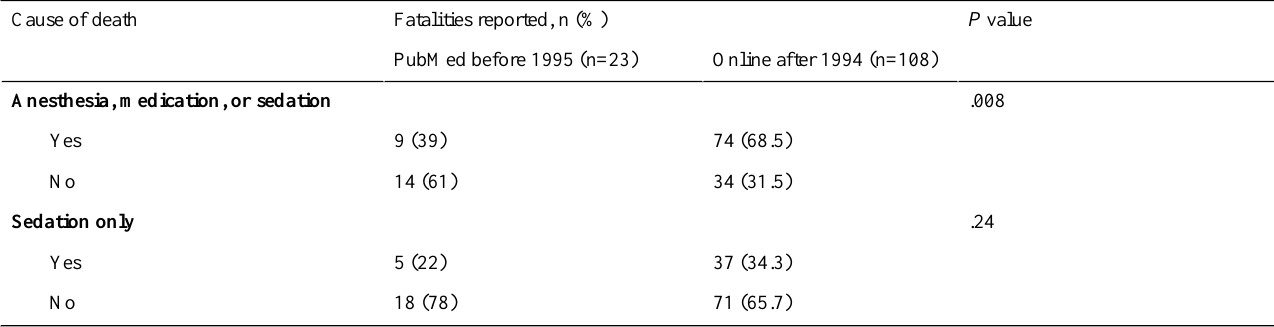
Table 11. Comparison of fatalities in dental facilities described in PubMed before 1995 and online after 1994 with respect to deaths assigned to the anesthesia, medication, or sedation and sedation-only